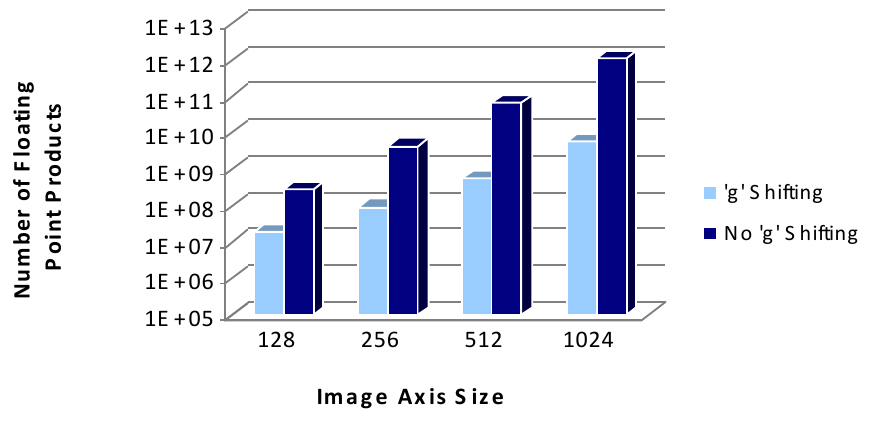
Figure 14. Computational complexity of normalized cross